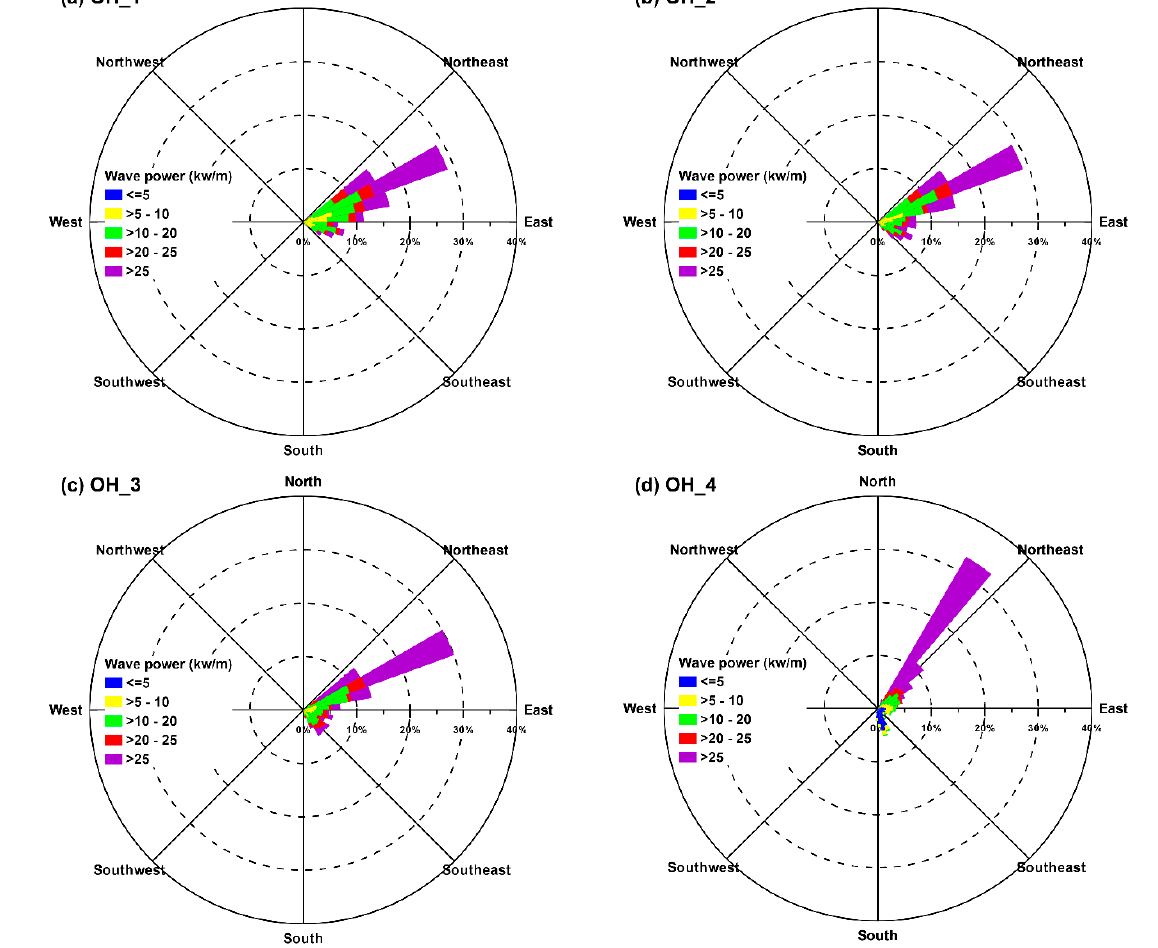
Figure 16. Directional distributions of the wave power averaged over 1991 to 2010 for four optimal wave energy hotspots: